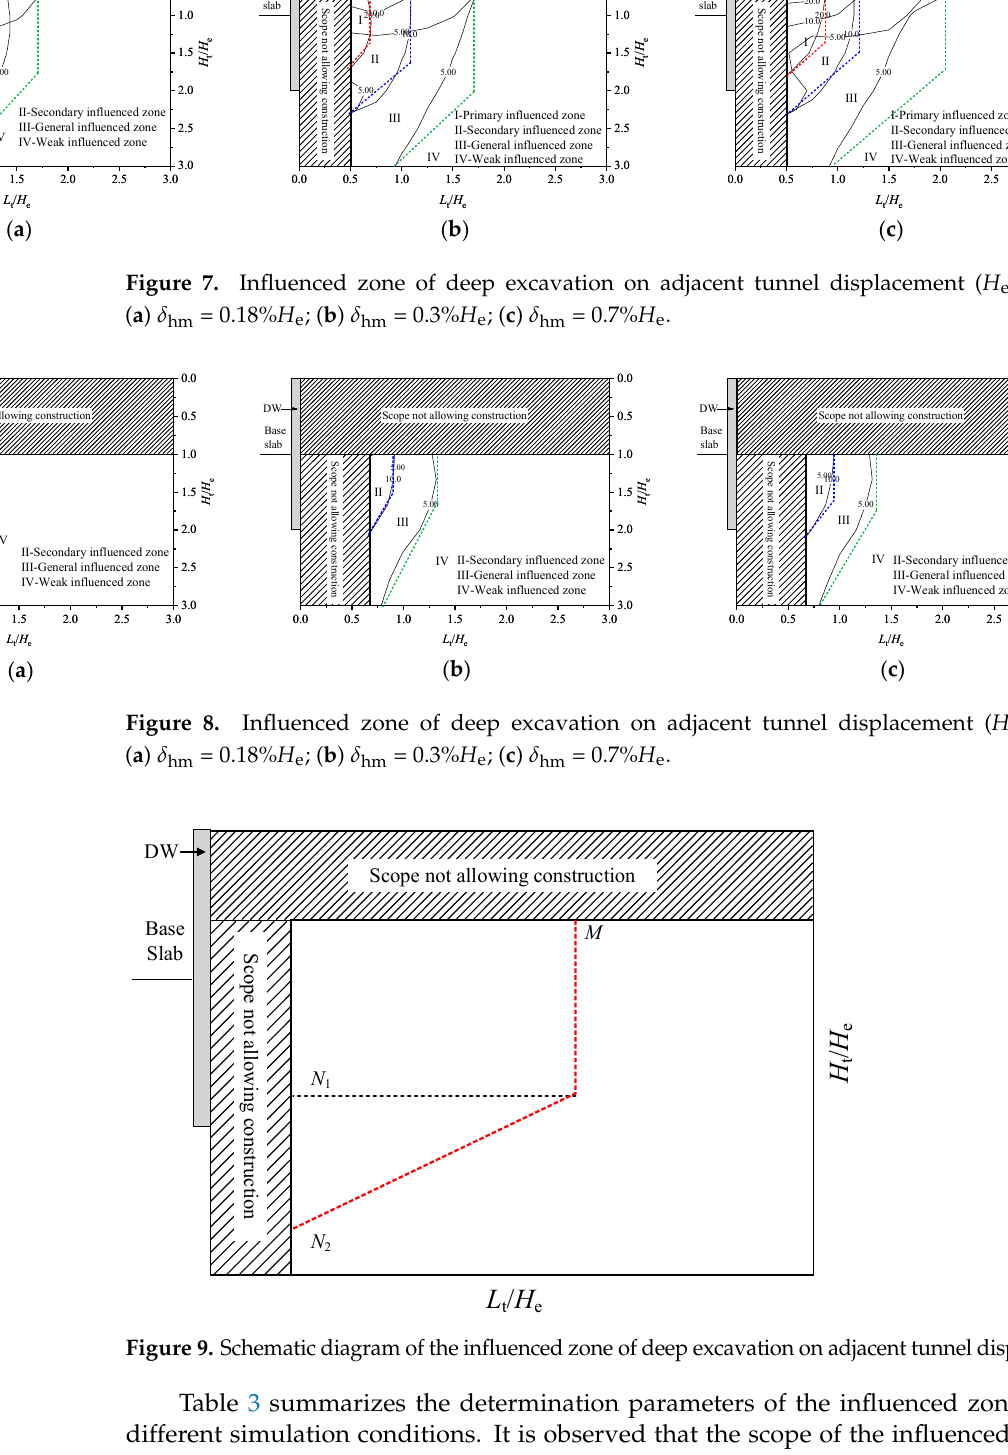
Table 3. Determination parameters of in fl uenced zones under di ff erent simulation conditions.